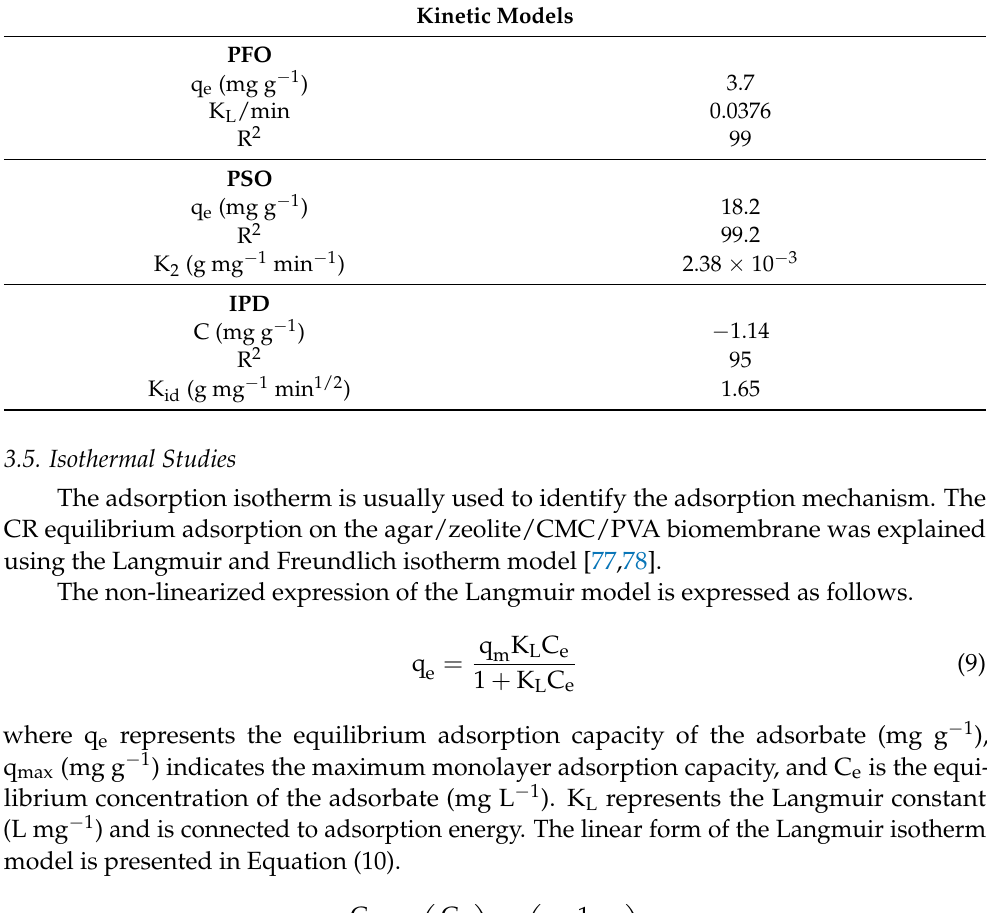
Table 6. Kinetic fitting constants of CR on agar/zeolite/CMC/PVA biomembrane. Kinetic